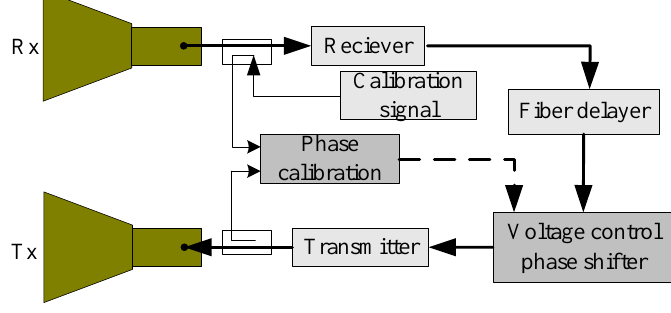
Figure 8. Phase calibration circuit scheme.